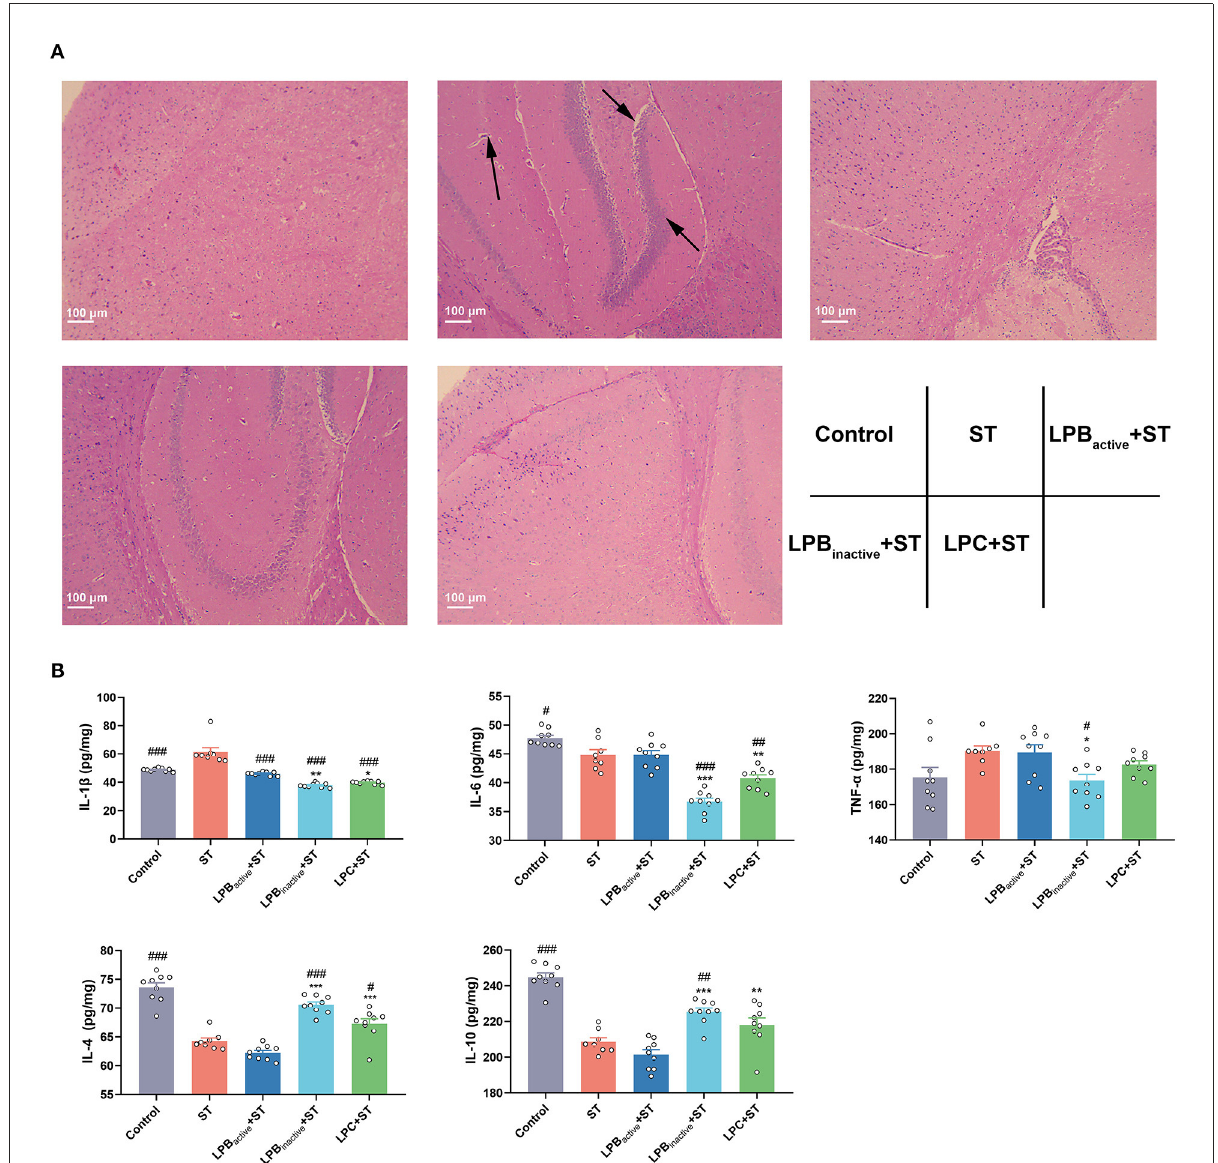
FIGURE4 The LP postbiotics alleviate ST-induced brain injury and inflammation in mice (A) H&E staining of brain structure. 100 × magnification, scale bar: 100 µ m. The arrows indicate the damaged spots. (B) Levels of inflammatory cytokines (IL-1 β , IL-6, TNF- α , IL-4, and IL-10) in brain. The data shown as mean ± SEM were analyzed by one-way ANOVA and Tukey’s test ( N = 8 or 9 in groups). # Indicates the significance compared to ST group: # p < 0.05, ## p < 0.01, ### p < 0.001. * Indicates the significance compared to LPB active + ST group: * p < 0.05, ** p < 0.01, *** p < 0.001.